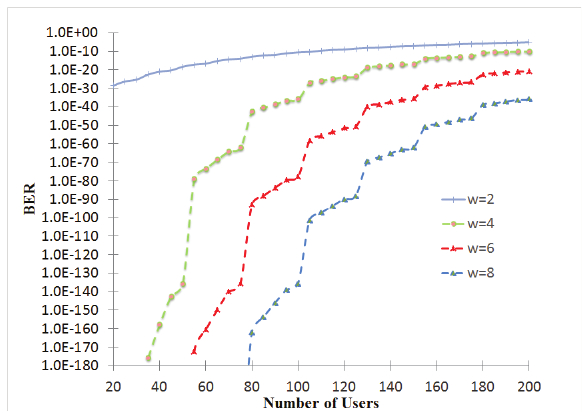
Fig. 5. BER versus number of